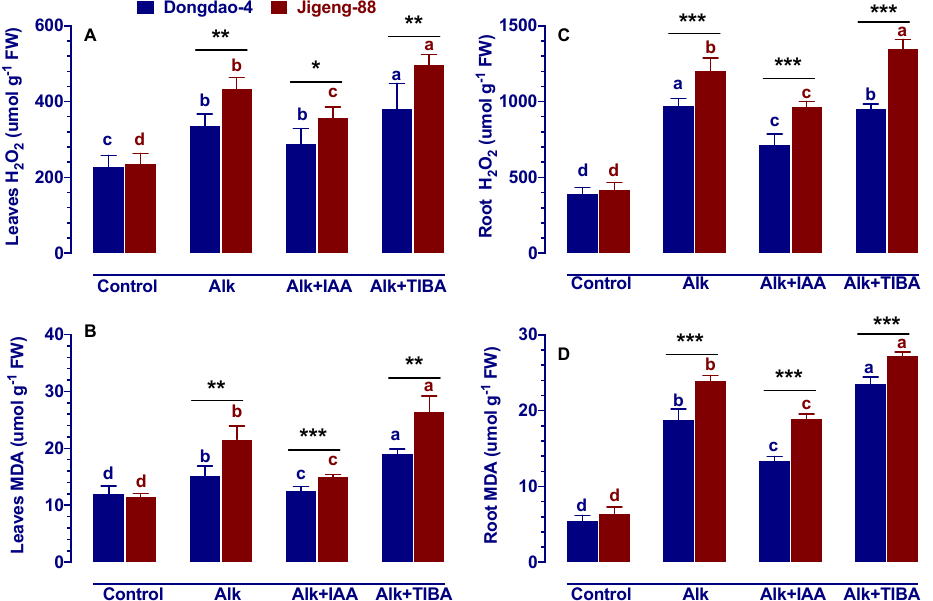
Figure 5. Effects of IAA and TIBA on contents of ( A , C ) H 2 O 2 , ( B , D ) malondialdehyde (MDA) of Dongdao-4 and Jigeng-88 seedlings after treatment with alkaline stress. Treatments were as described in Figure 1. Means with different letters are significantly different ( p < 0.05) between control and “Alk” and “Alk + IAA” and “Alk + TIBA” of the same genotype. Asterisks indicate significant differences between different genotypes within the same treatment (* p < 0.05, ** p < 0.01, *** p <